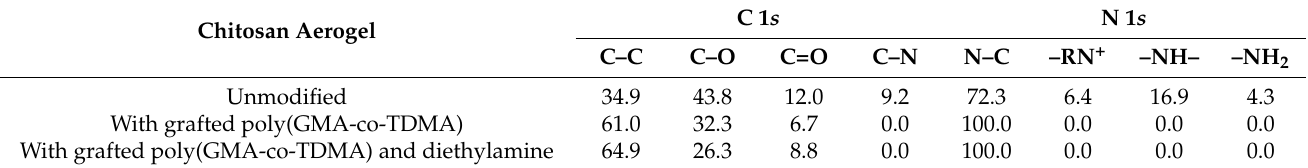
sizes are 100–300 µ m, and the pore walls are made of films with a thickness of 0.6–1 µ